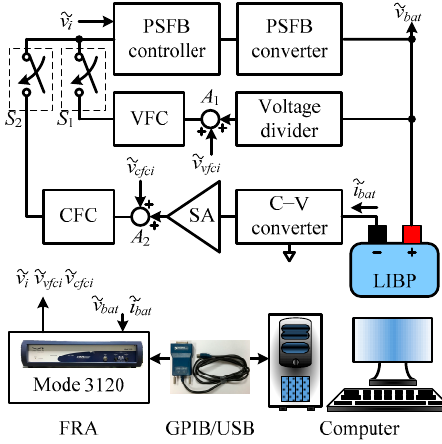
Figure 20. Measurement system of frequency response for LBPRC.